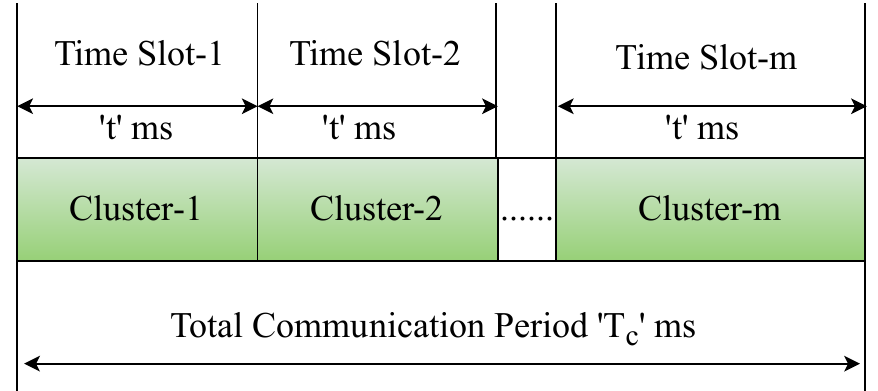
Figure 3. Time slot allocation for different clusters in TDMA-RIS-NOMA downlink system. When a new time slot starts, only one user device is communicating through one RIS. The number of user devices active in any time slot is equal to the number of RIS deployed ( n ) in the system. During the present time slot, these n active devices receive a common broadcasted composite NOMA signal through different wireless channels (i.e., AP-to-RIS-to-user device). This received NOMA composite signal is decoded at the receiver (user device). The realization of time synchronization and frequency distribution among different resource blocks are conducted as described in [16] for NB-IoT